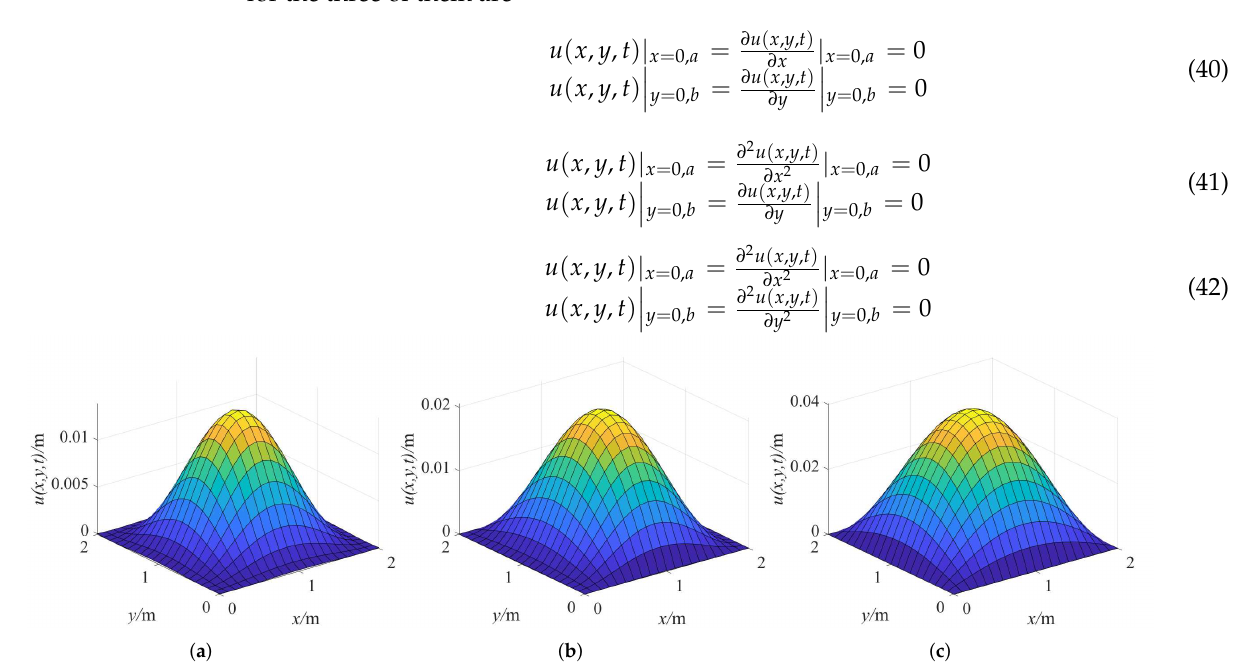
Figure 5. Displacements of the plate under external load F = 0.08sin ( 0.01 t ) at different bound- ary conditions for ( a ) CCCC. ( b ) SSCC. ( c )